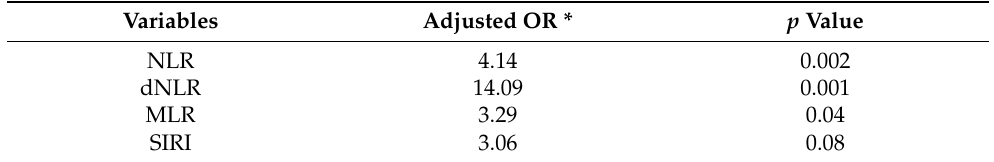
Table 4. The adjusted OR in each of the NLR, d-NLR, MLR and SIRI. Variables